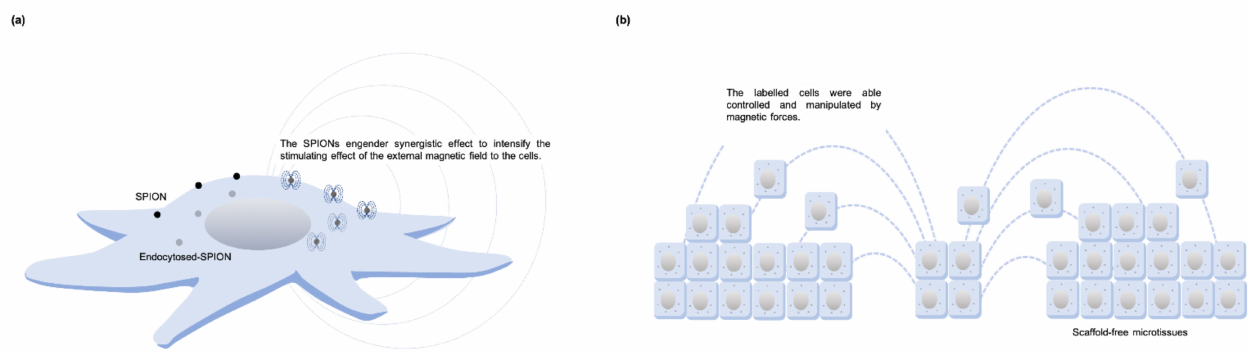
Figure 8. Illustration of SPION-labeled cells. ( a ) SPIONs can be endocytosed, exocytosed, and metabolized by cells. When external SMF is applied, SPIONs reveal their magnetic properties and modulate background magnetic fields; ( b ) Combined with the SPIONs, labeled cells can be patterned by an accurate spatial and temporal magnetic force to form a